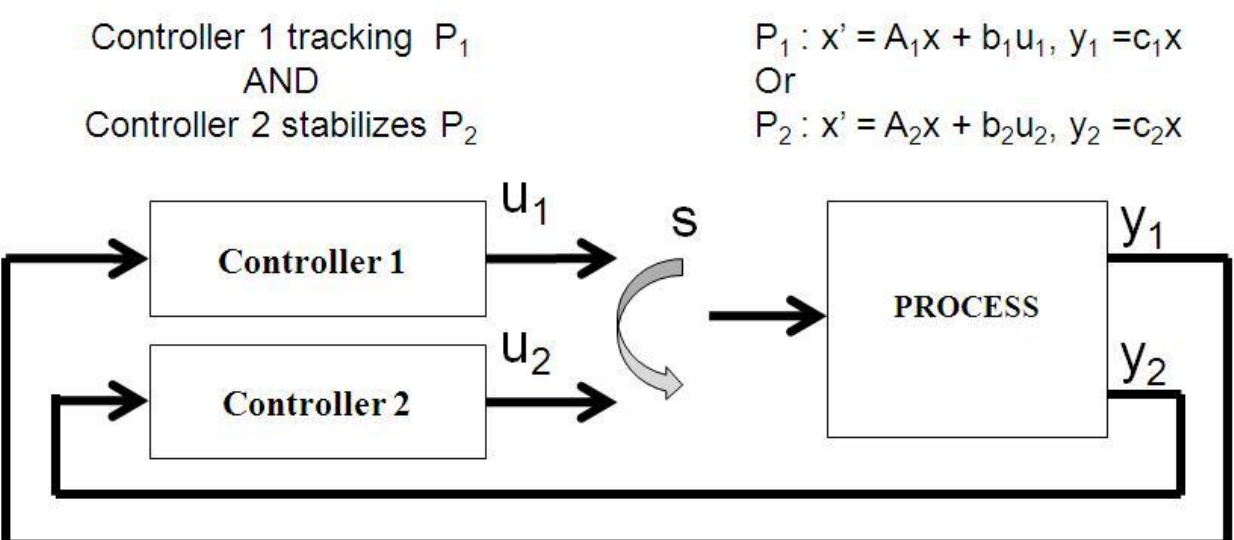
Figure 4. Concept of sun tracking control